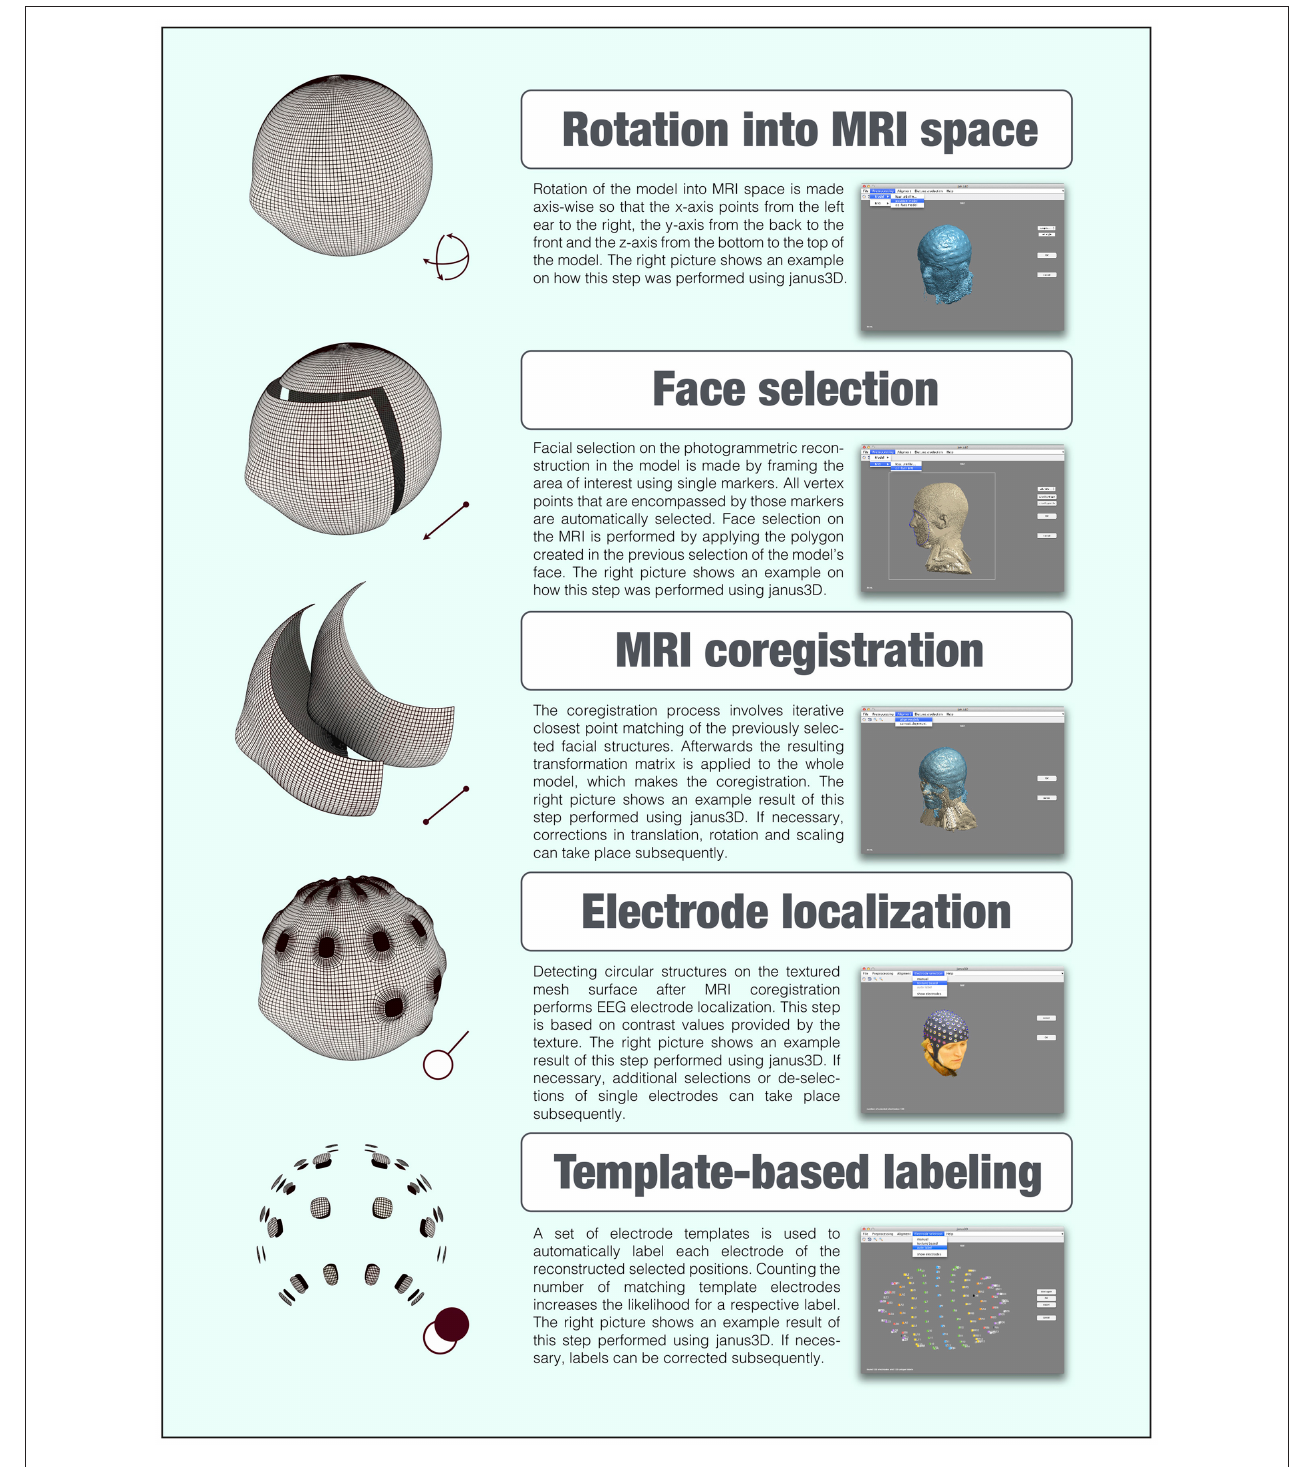
FIGURE 5 | Flowchart depicting the general janus3D work